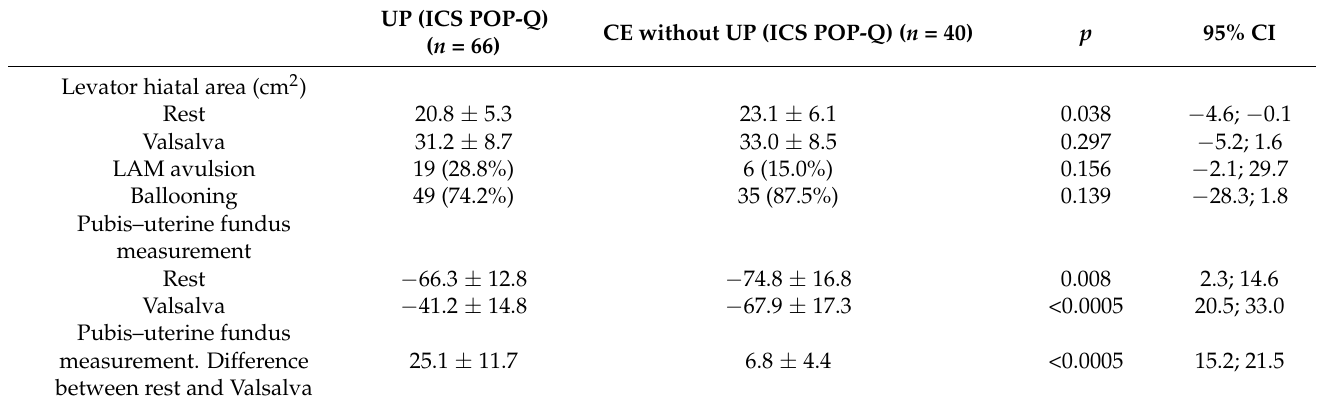
Table 2. Ultrasound data according to the presence of uterine prolapse (UP) or cervical elongation (CE) without UP.